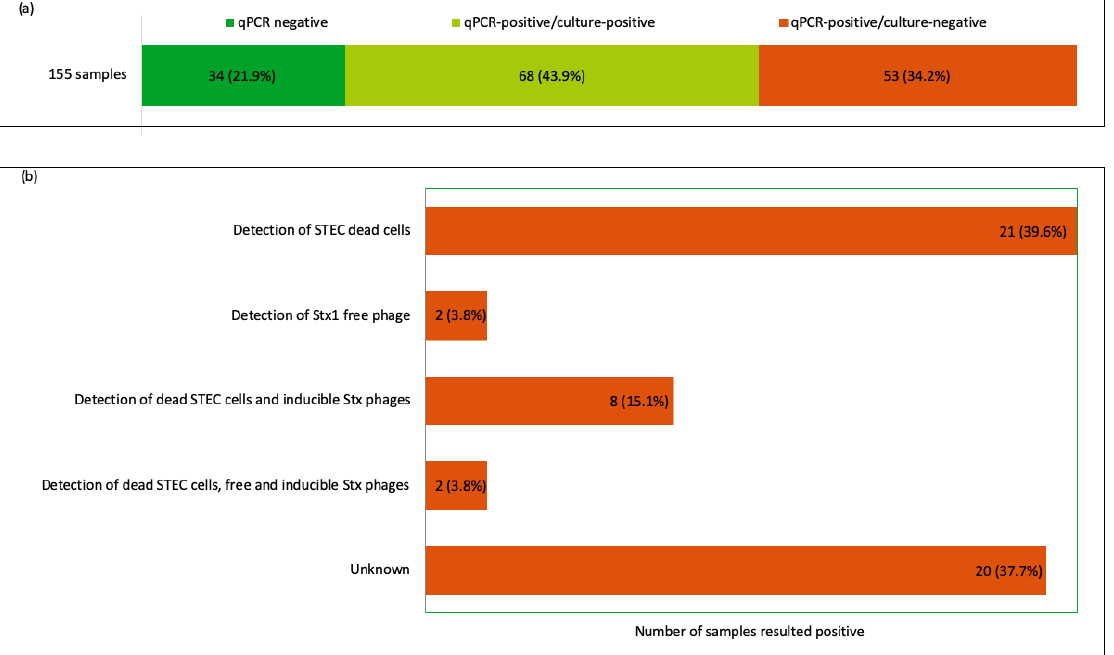
Figure 2. Results of the approaches used in this study. ( a ) Results of the STEC screening (method a) of the o-RAJ samples ( n = 155). ( b ) Results of the combination of the methods used to investigate the qPCR-positive/culture-negative phenomenon ( n = 53).